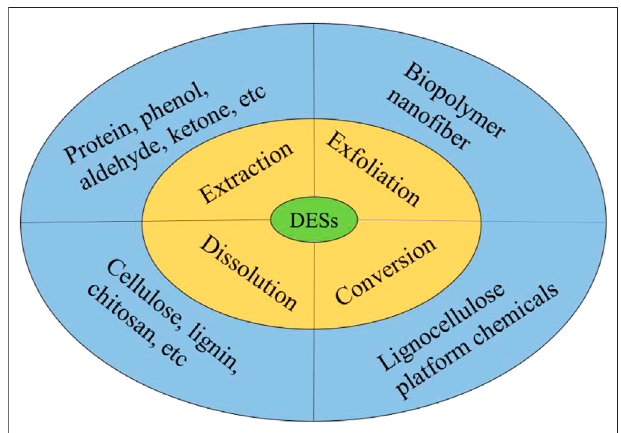
FIGURE 5 | Common DESs are used for biomass treatment and conversion. Adapted with permission from Chen and Mu